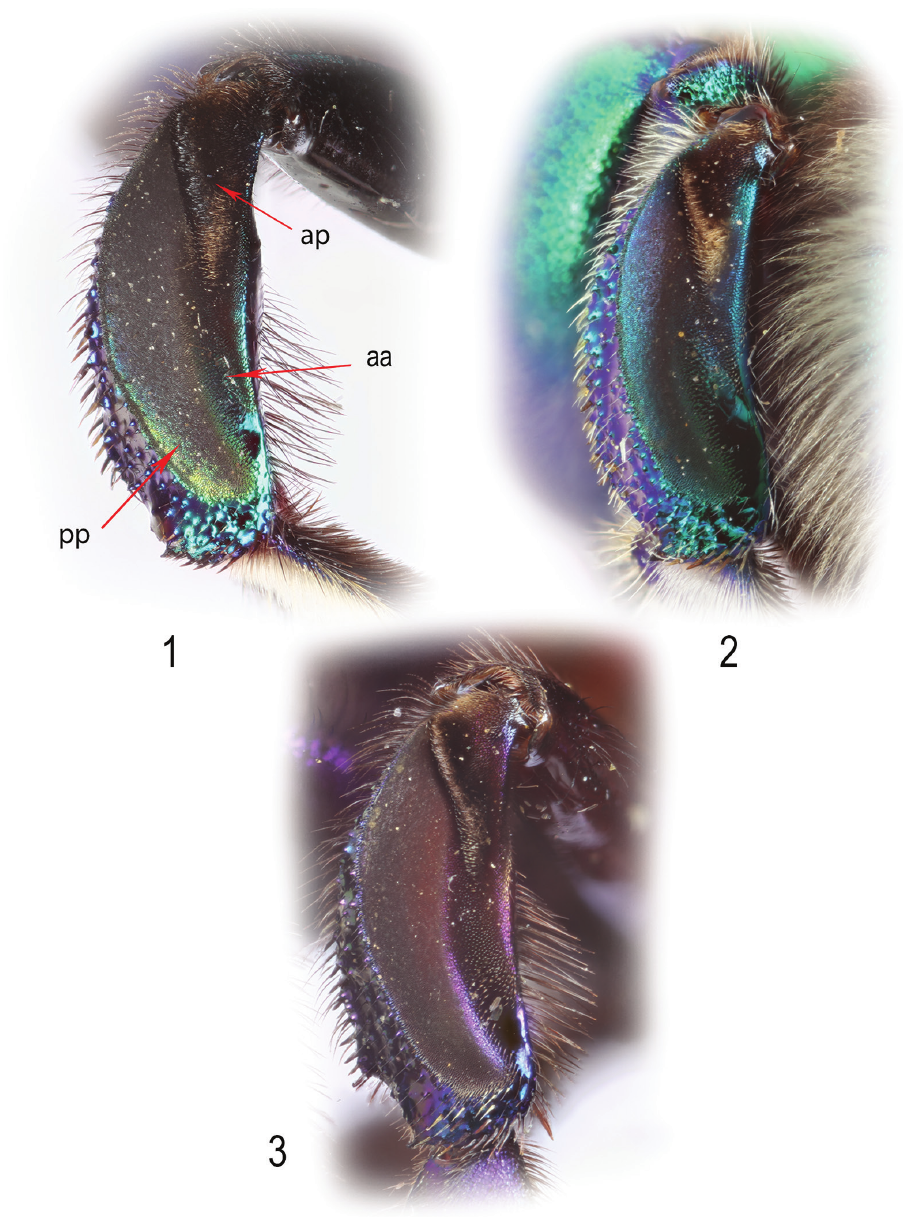
Figures 1–3. Male mesotibia showing anterior (ap) and posterior (pp) felty patches. The presence or absence of setae in the area between the medial margin of the posterior patch and the anterior margin of tibia (aa) distally, is an important feature in species identification. 1 E. coerulescens (Mexico: Nuevo León; ECO-TAP-E-104040) 2 E. oliveri (holotype) 3 E. simillima